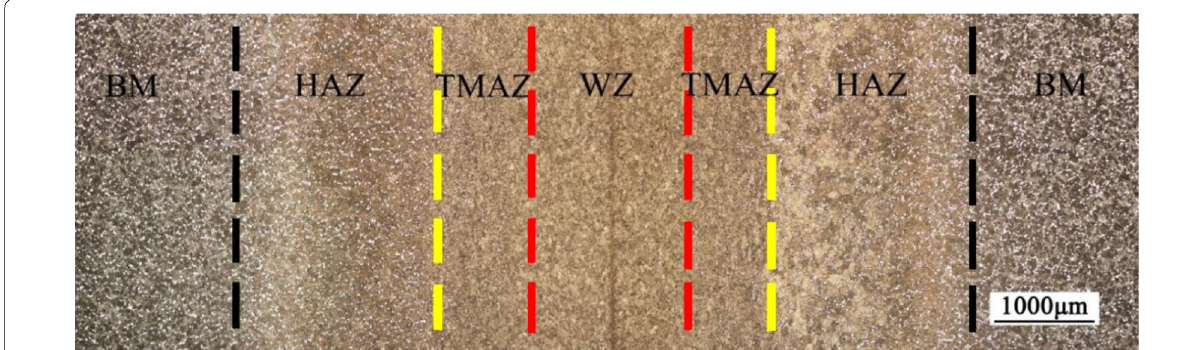
Figure 5 Microstructure of the inertia friction welded TA19